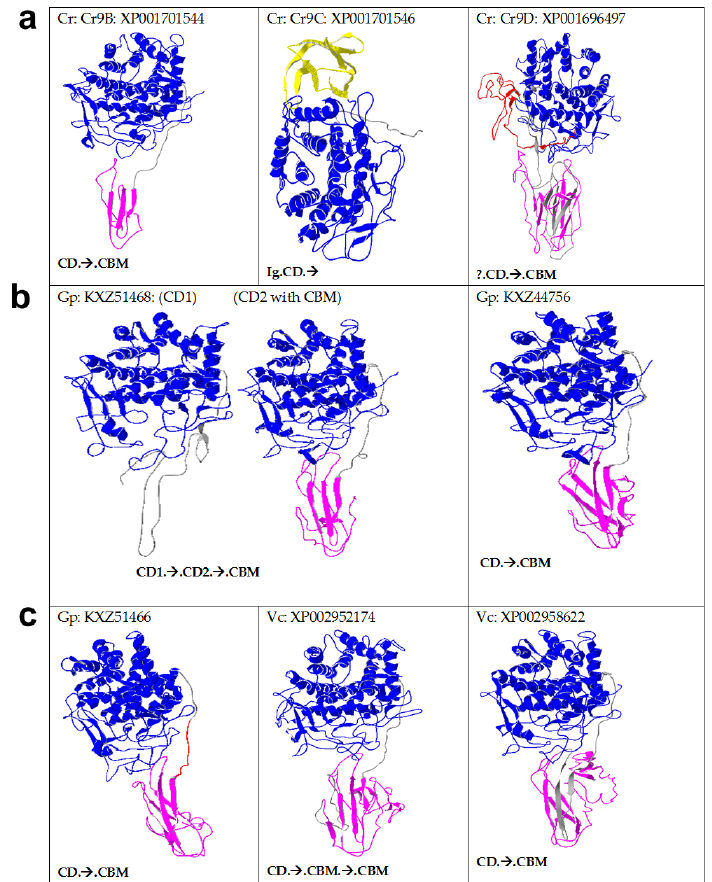
Figure 3. Homology models of selected family GH9 cellulases. Blue, CD (catalytic domain); pink, CBM (carbohydrate binding module); grey, linker; yellow, Ig-like domain; red/?, unknown. Organism names, accession/PDB codes, and cellulase types are given alongside the structures. ( a ) Cr, Chlamydomonas reinhardtii ; ( b ) and ( c ) Gp, Gonium pectoral and Vc, Volvox carteri . The X-ray structures of templates (PDB: 1JS4/4TF4, 1KFG/1GA2, 1UT9, 1KS8, 1CLC and 2YIK) used by I-TASSER for